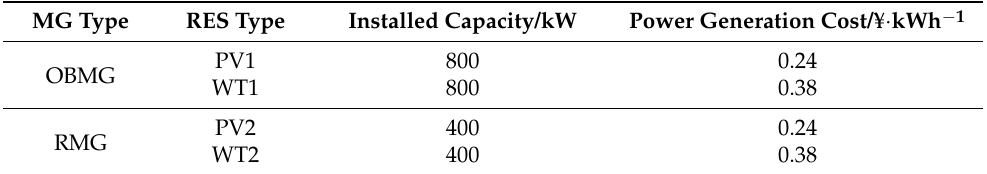
Table 1. Installed RESs and the power generation cost.